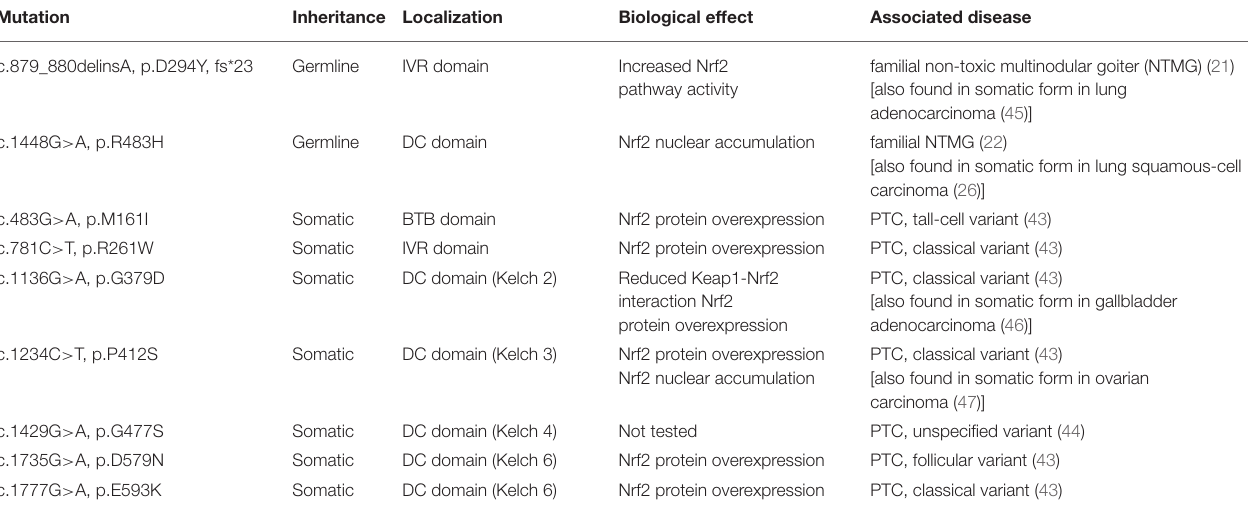
TABLE 1 | List of KEAP1 mutations involved in benign and malignant thyroid diseases. Mutation Inheritance